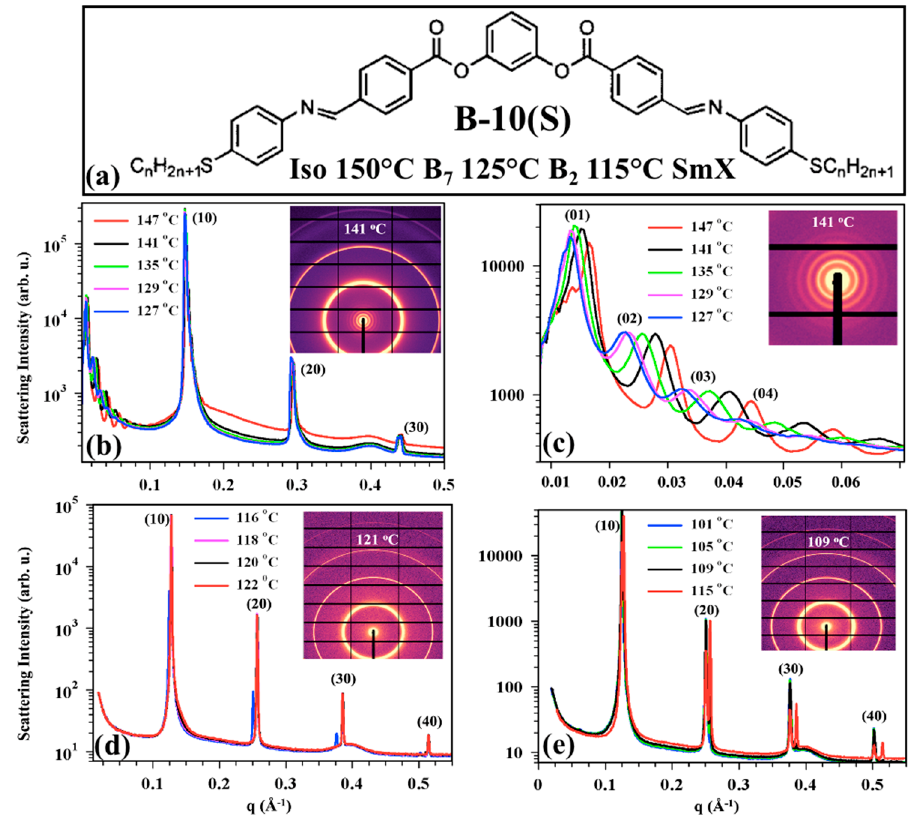
Figure 1. Molecular structure of B-10(S) and summary of small angle X-ray scattering (SAXS) results of B-10(S). ( a ) Molecular structure and observed phase sequence. ( b , c ) Scattering intensity versus q in the B 7 texture in 0.01–0.5 Å − 1 range ( b ) and 0.01–0.06 Å − 1 range ( c ) at selected temperatures. Insets show the 2-D scattering image at 141 ◦ C; ( d ) Scattering intensity versus q in the B 2 phase in 0.01–0.5 Å − 1 range at selected temperatures (inset: 2-D scattering image at 121 ◦ C); ( e ) Scattering intensity versus q in the SmX phase in 0.01–0.5 Å − 1 range at selected temperatures (inset: 2-D scattering image at 109 ◦ C). The broad peak at 0.4 Å − 1 is due to the Kapton tape used as a window in the SAXS measurements.